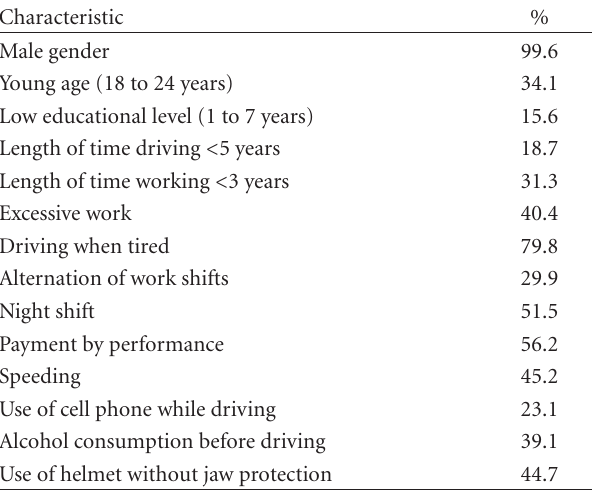
Table 1: Characteristics of the study population ( n =